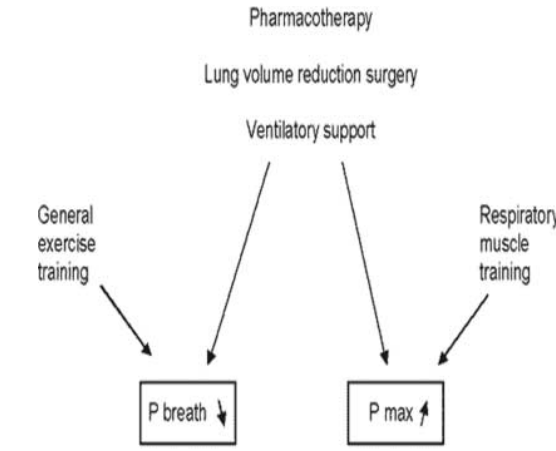
Therapeutic options aiming at the correc- tion of imbalance between respiratory muscle load (P breath ) and capacity (P max ) in